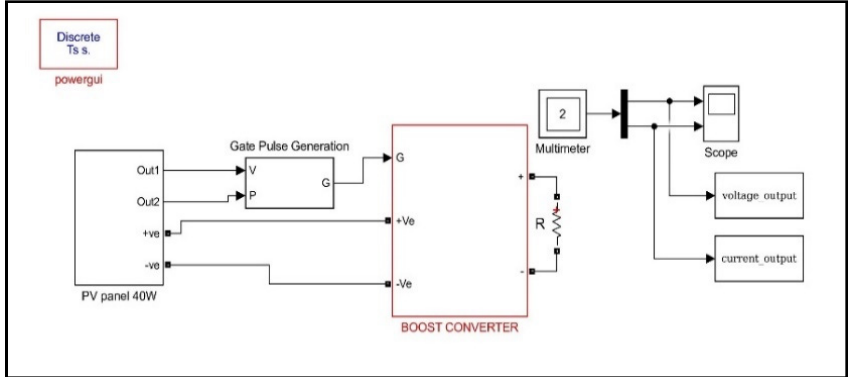
Figure 12. MATLAB Simulink model for hardware.